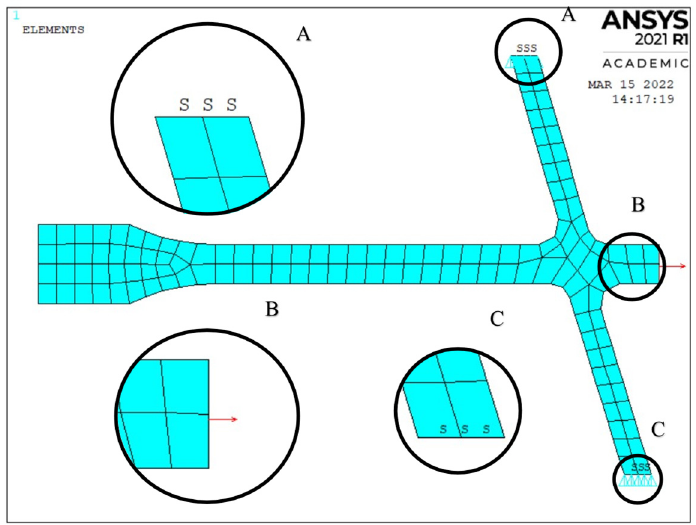
Figure 3. Discretised disc model with marked boundary conditions, where: A and C—symmetry condition zone, B—rim pull zone.